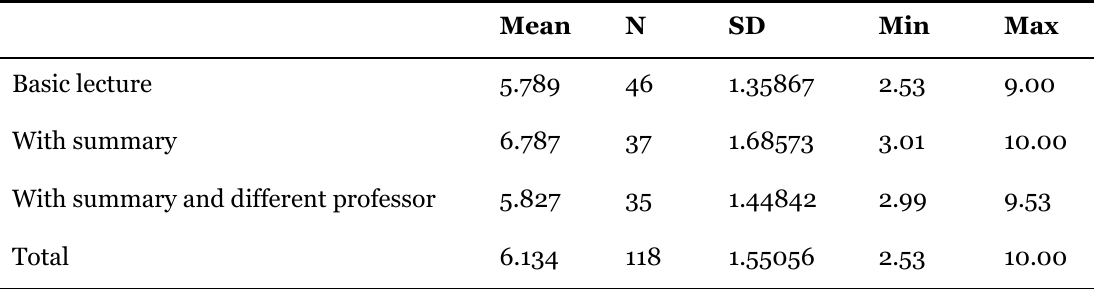
Table 3 Mean Quiz Score for Each Experimental Condition Mean N SD Min Max Basic lecture 5.789 46 1.35867 2.53 9.00 With summary 6.787 With summary and different professor 5.827